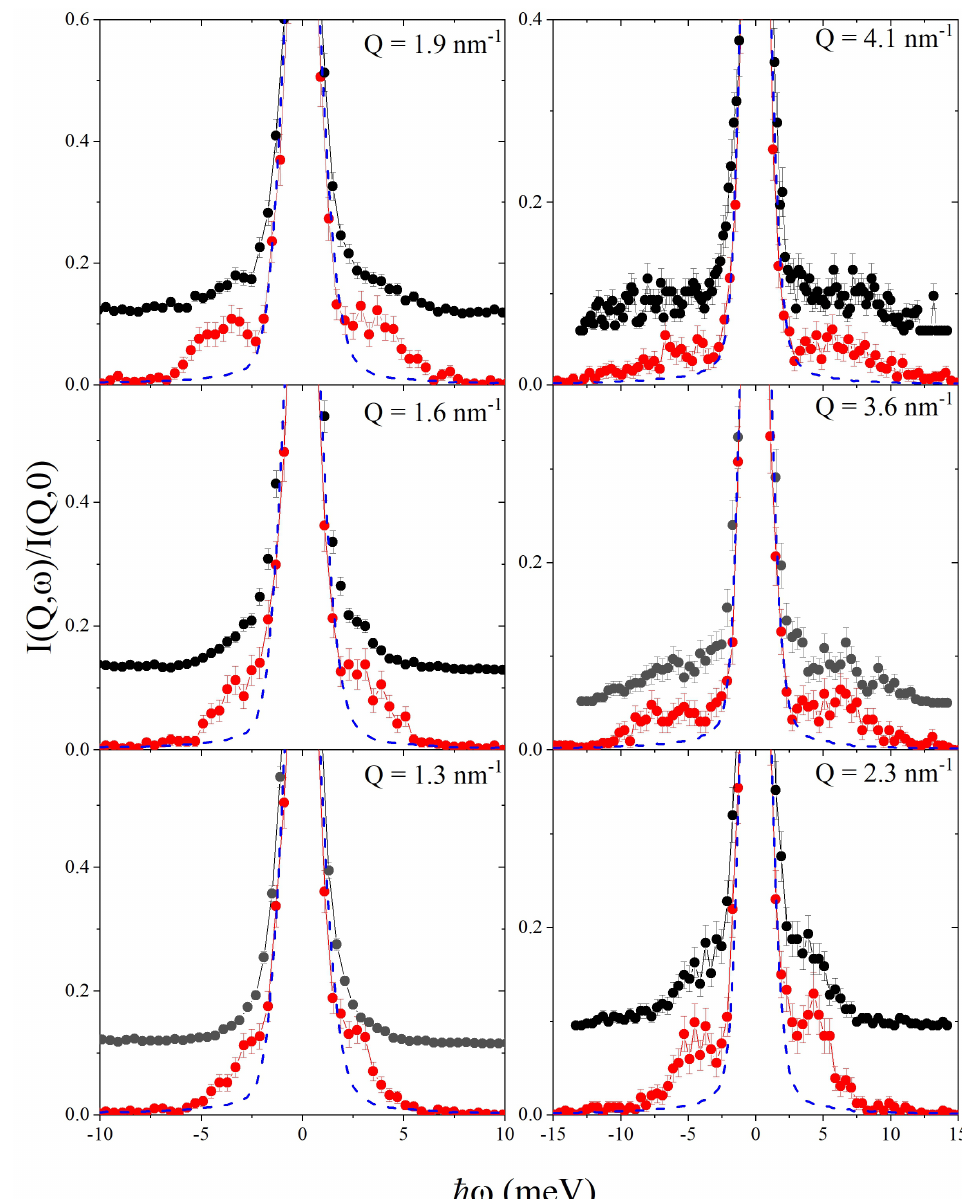
Figure 2. Inelastic X-ray Scattering (IXS) spectra measured at the indicated wave wavevector transfer Q values on pure glycerol (red dots) and on the Au-NP suspension in glycerol (black dots) are reported along with the instrumental energy resolution function (dashed blue lines). All lineshapes are normalized to the respective maximum intensity; those from the nanoparticle suspension are also vertically shifted for